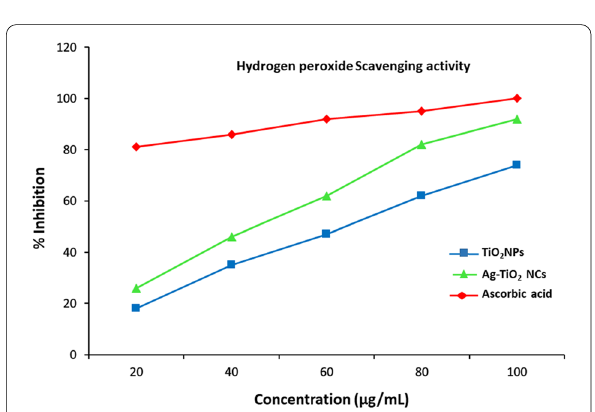
Fig. 10 H 2 O 2 assay showing enhanced antioxidant activity of green-synthesised Ag–TiO 2 NCs at different